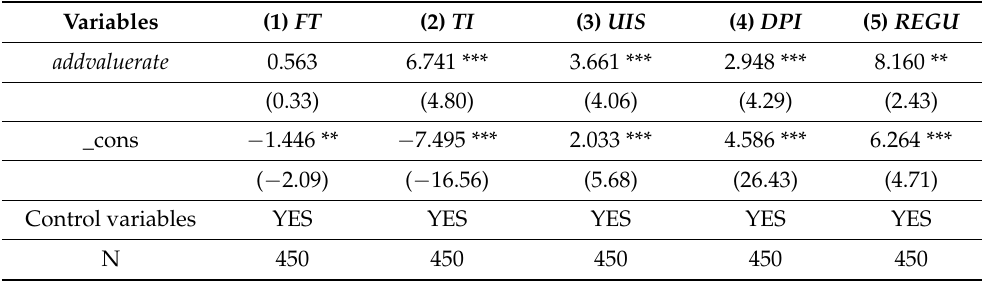
Table 8. Regression results of mechanism